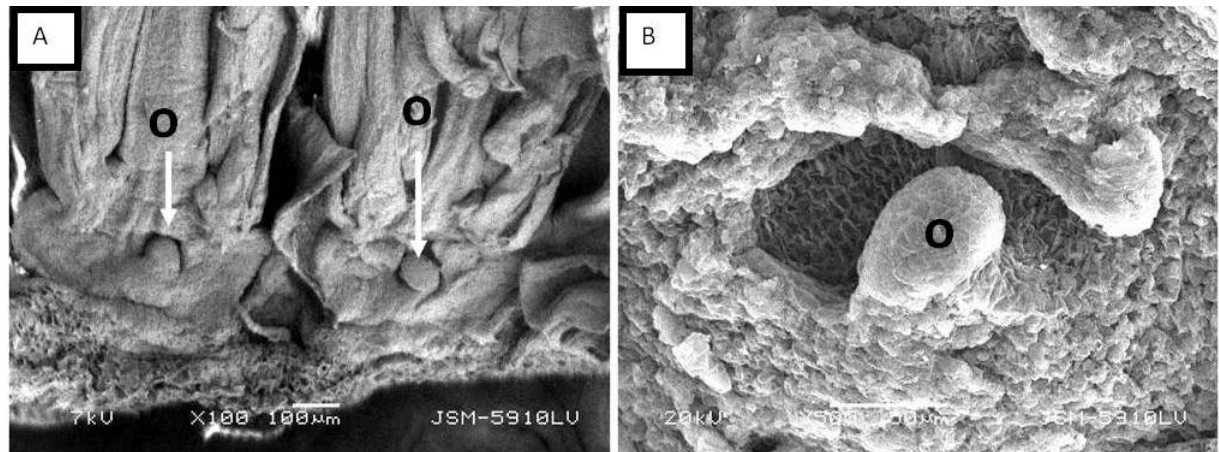
ing to curve. O: Ovule